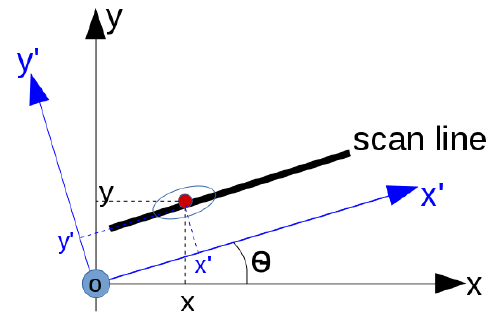
Figure 3. A local coordinate frame x (cid:48) - o - y (cid:48) with respect to a scan cross-section and a global coordinate frame x - o - y